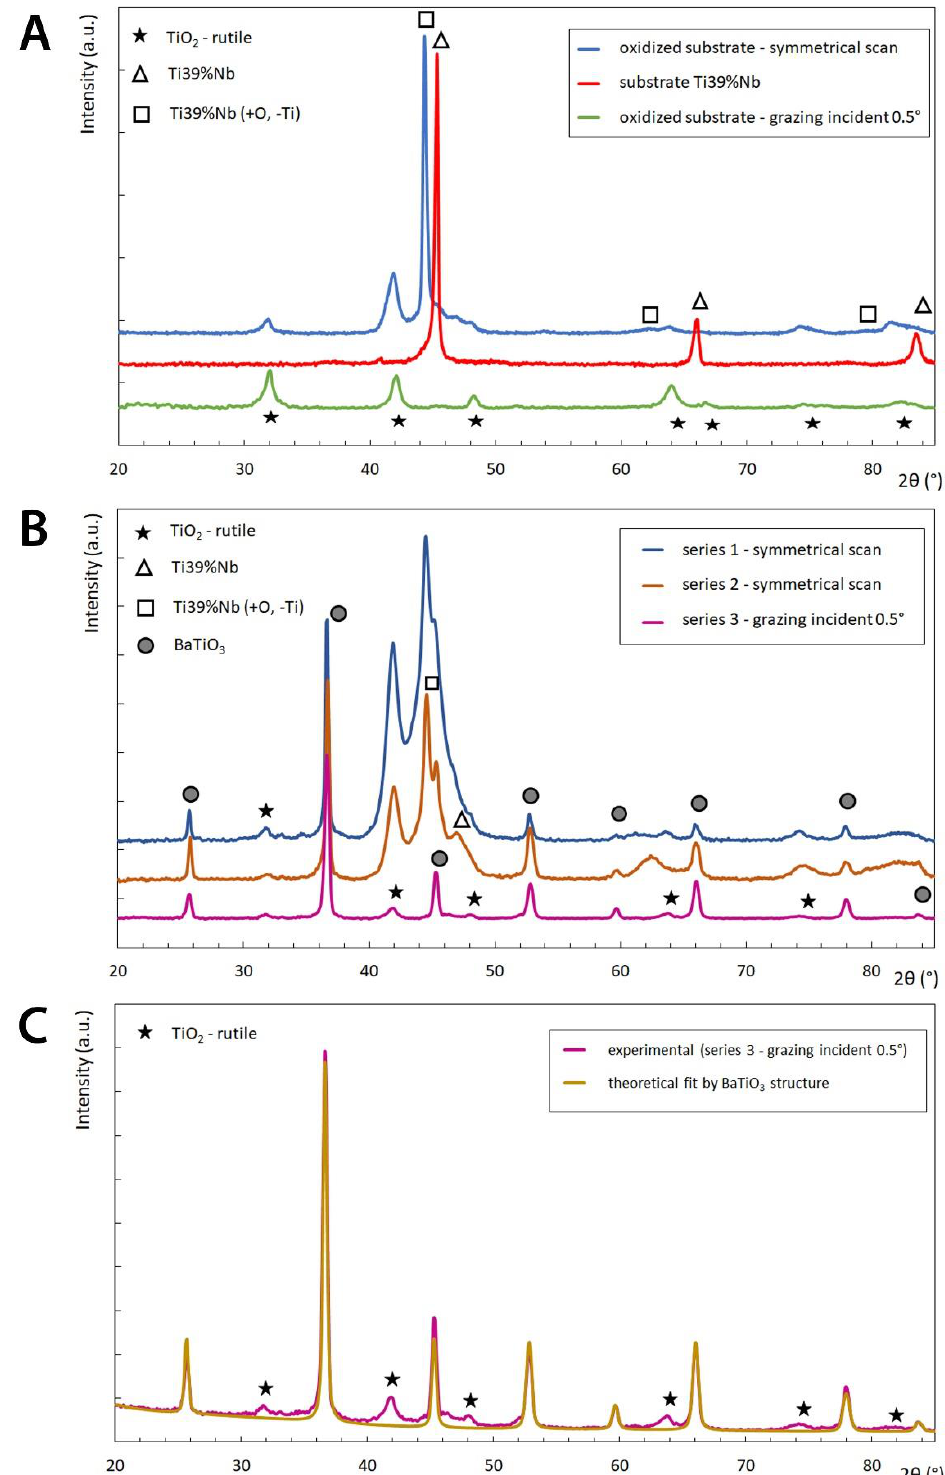
Figure 3. The diffraction patterns of the original and oxidized Ti39Nb substrates ( A ) and of BaTiO 3 film deposited on Ti39Nb substrates ( B ). XRD data for Series 3 sample measured with grazing incident angle of 0.5° fitted by BaTiO 3 phase. Not-fitted intensity corresponds to TiO 2 rutile phase ( C ). The analysis was performed on almost the entire surface (0.79 cm 2 ) of one sample per each experimental group (i.e., non-oxidized Ti39Nb, oxidized Ti39Nb, and BaTiO 3 of series 1, 2 and 3).